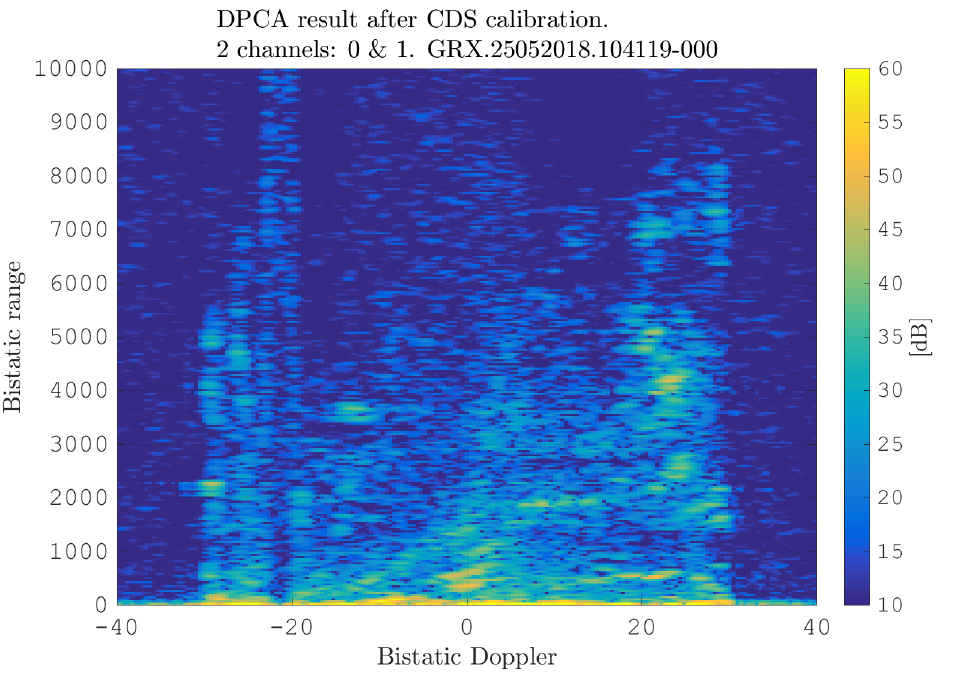
Figure 14. Range-Doppler map after calibration using CDS and clutter suppression using DPCA.